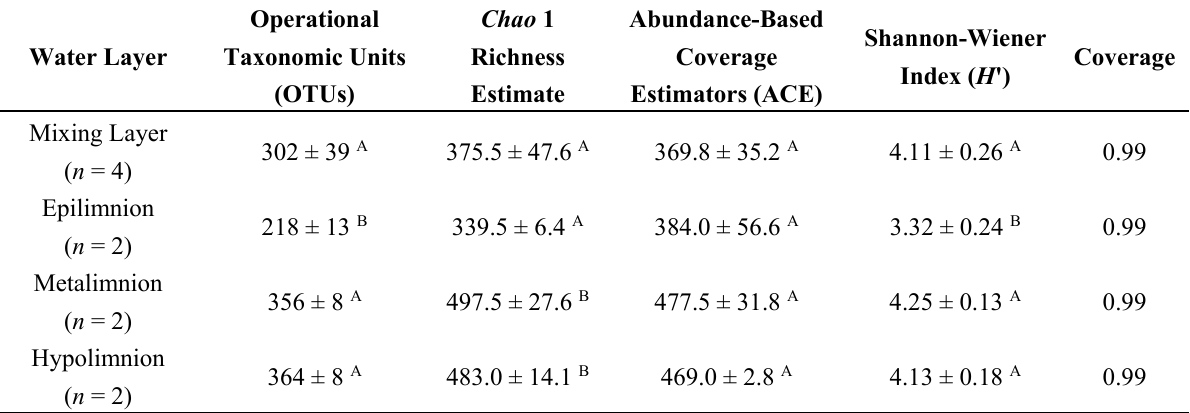
Figure 5. Taxonomic classification of sequences of the bacterial communities in Site C from the Jinpen Drinking Water Reservoir, China. Sequences were classified at the phylum level using the Ribosomal Database Project (RDP). Table 3. Similarity-based operational taxonomic units (OTUs) and species estimates of pyrosequencing result of each water layer in the Jinpen Drinking Water Reservoir,